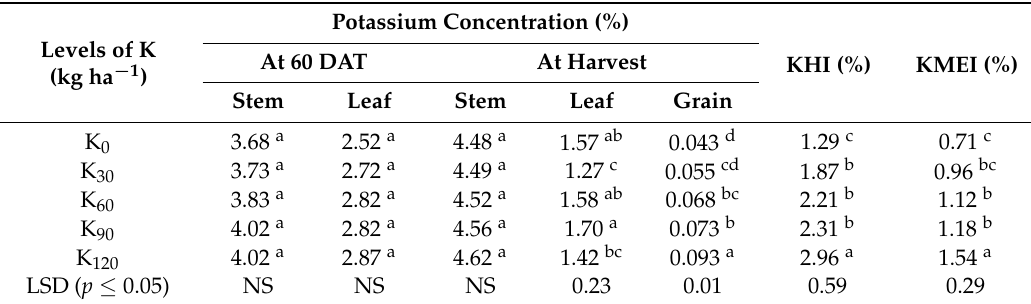
Levels of K (kg ha − 1 ) Table 4. Potassium concentration (%) in different plant parts, mobilization, and utilization by hybrid rice (var. Arize 6444) as influenced by potassium fertilization (means for 2016 and 2017).